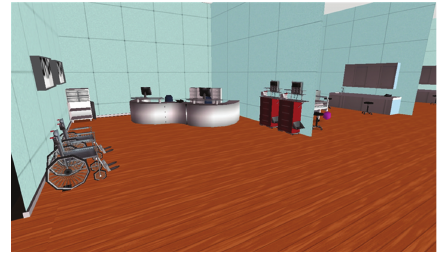
Figure 1: Second life nursing station.